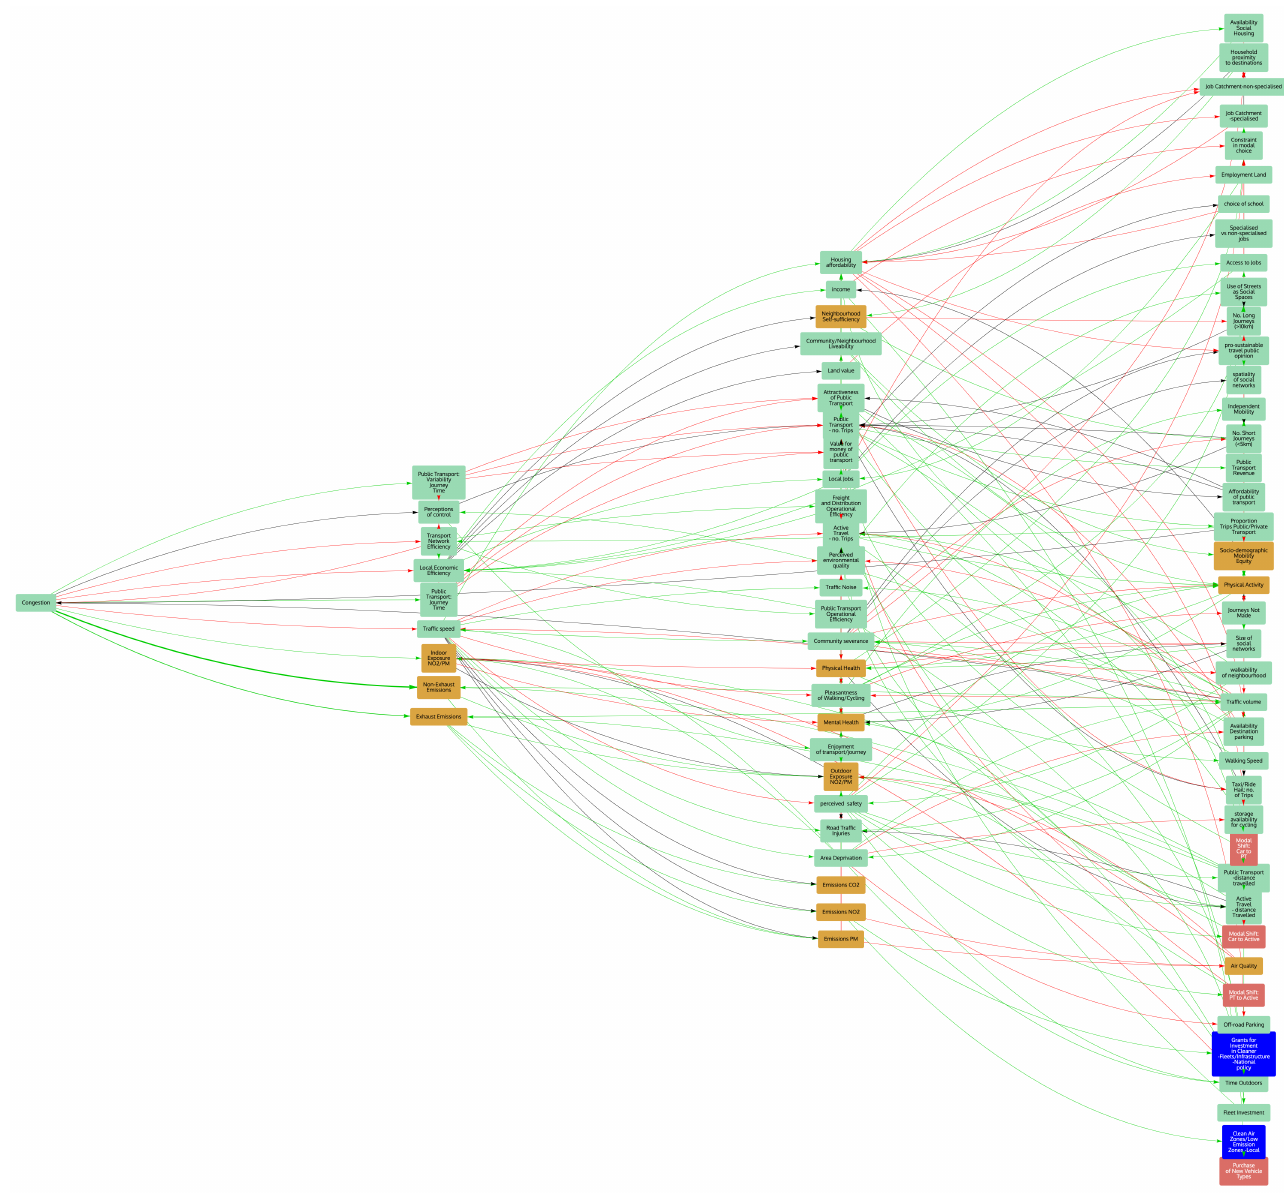
Figure 4. Congestion: downstream 3